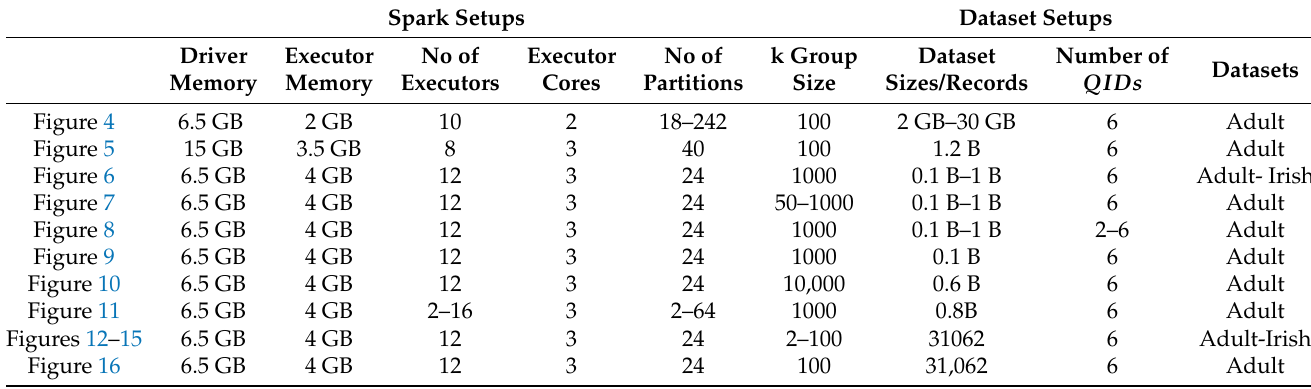
Table 7. Spark and dataset setup